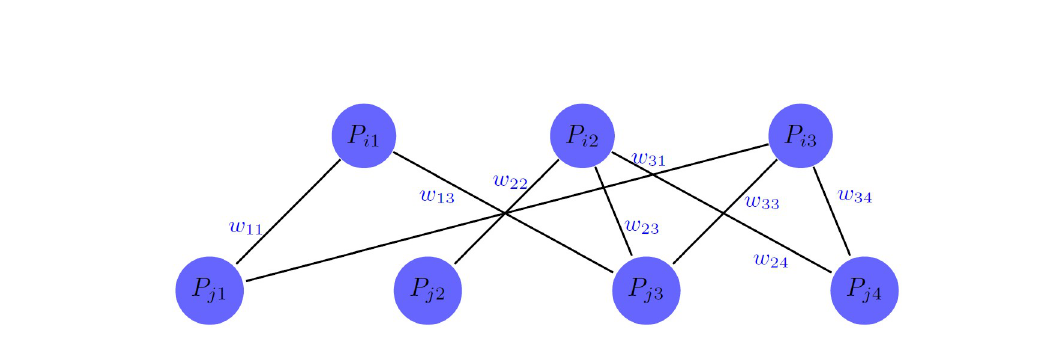
PLOS ONE | https://doi.org/10.1371/journal.pone.0250620 April 29,